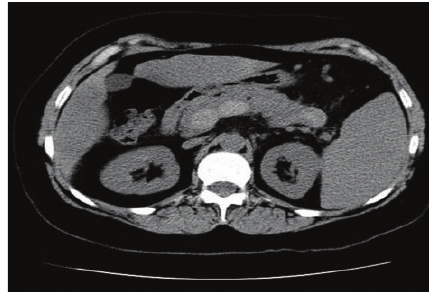
Figure 2: CT demonstrating splenic thrombosis.